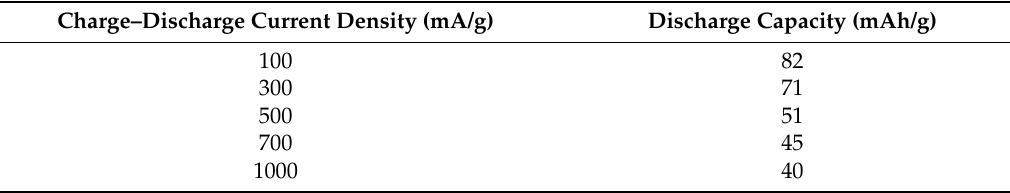
Discharge capacity of 10 mg/cm 2 graphite electrode at various charge–discharge current densities.